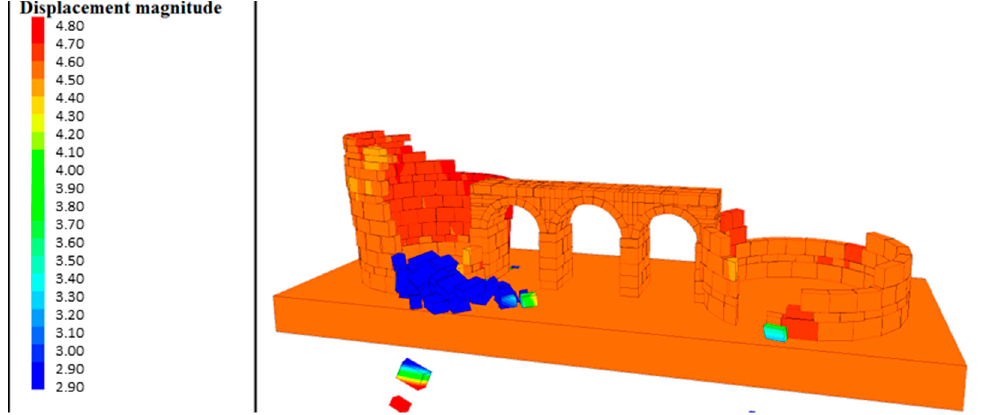
Figure 12. Displacement magnitude for ground motion level 1, under 30% of the first synthetic earthquake combined with 100% of the second synthetic ground motion.